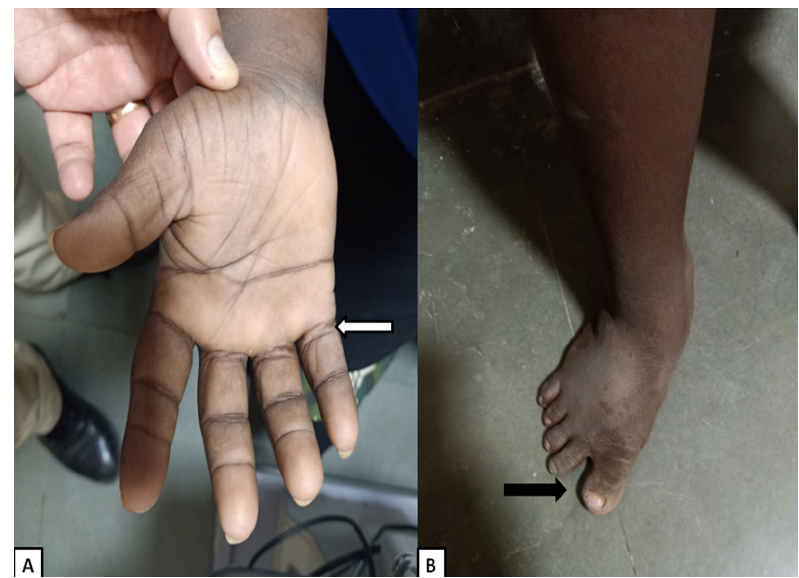
Figure 3: A: Image of the patient’s hand depicting short broad hands, short fifth finger, and single palmar crease. B: Image of the patient’s leg depicting widened gap between first and second toe (sandal